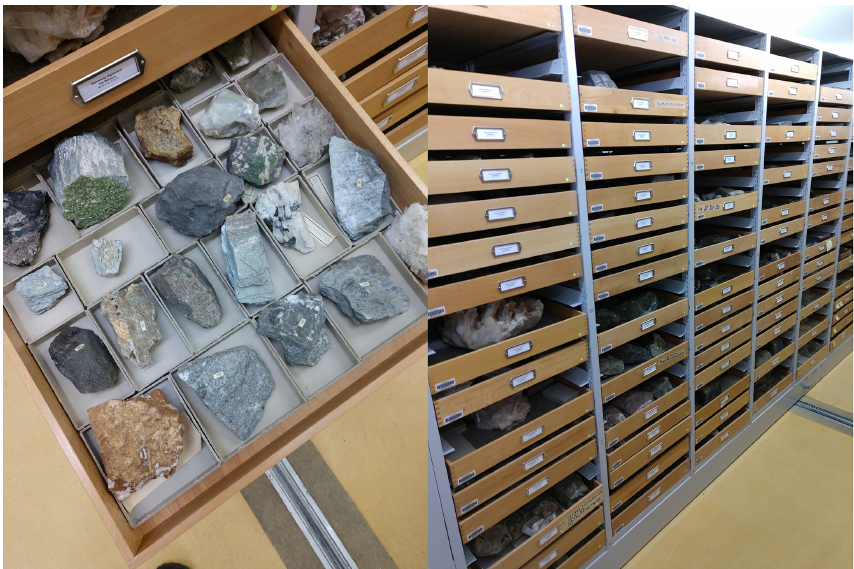
Figure 2. Pietro Sigismund collection housed in ETH Zurich, focusing on specimens from Valmalenco. Photo: Martin Jensen taken 28 March